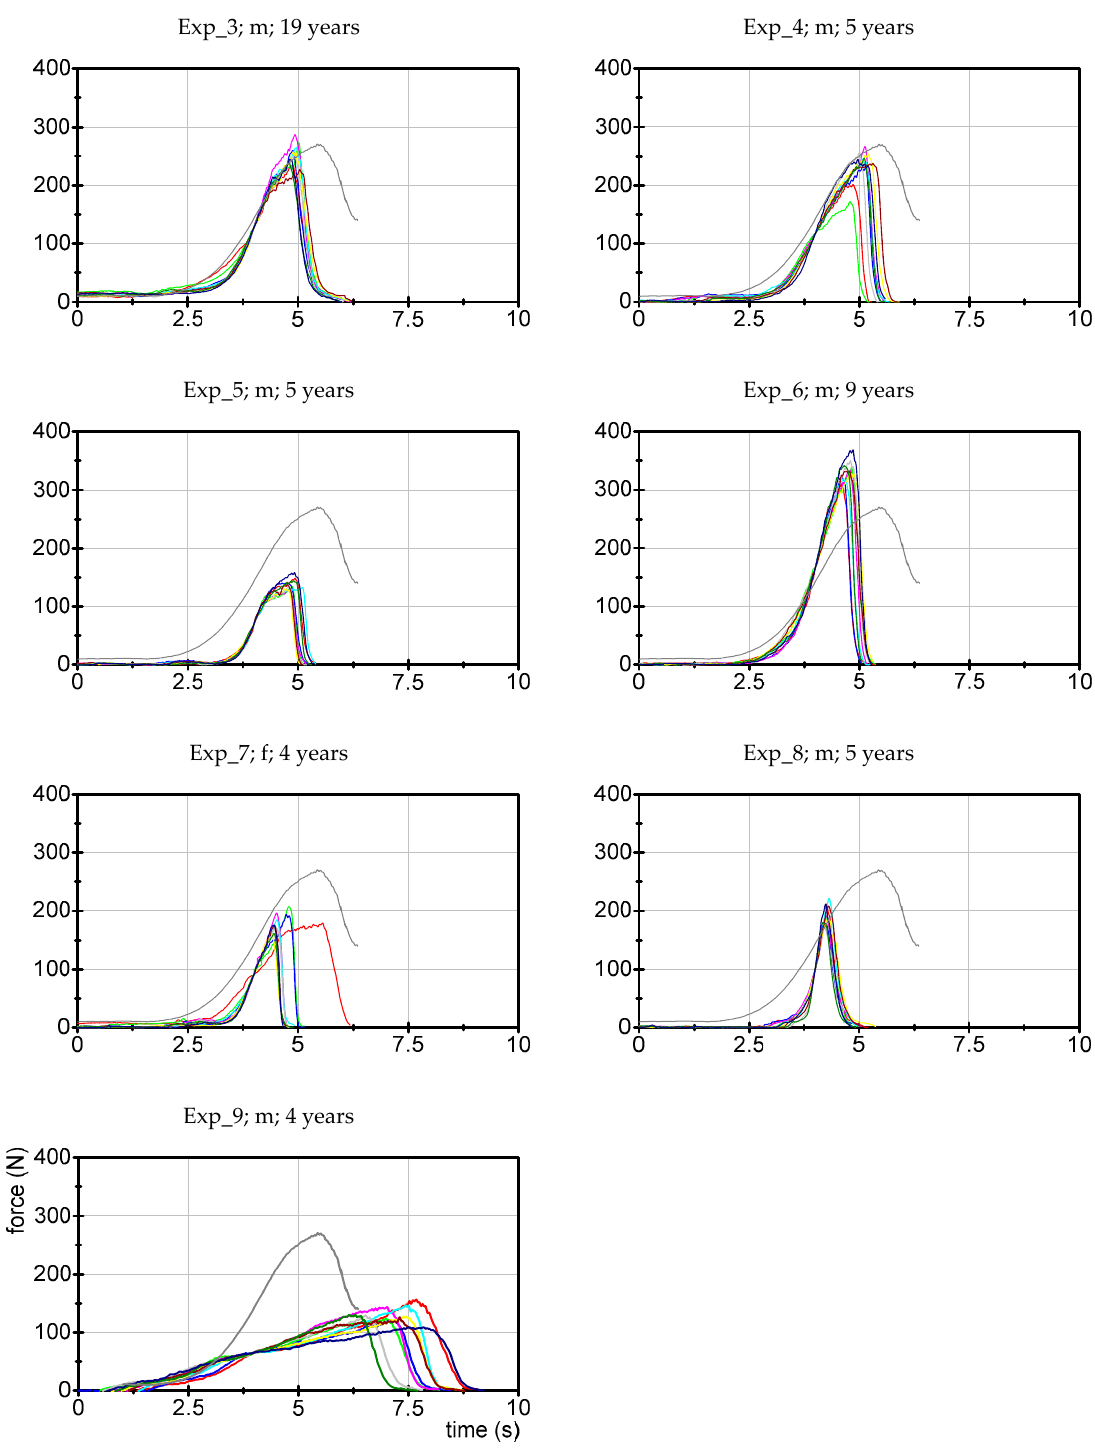
Figure 3. Force profiles of experienced testers. Displayed are the 10 individual force profiles of the n = 9 experienced testers (Exp). The grey curve displays the suggestion of a standardized force profile (see discussion). To have a better comparison, the x - and y -axis are standardized (0–10 s and 0–400 N). The ID (Exp_no.), gender (f = female, m = male) and the years of experience are given per tester.